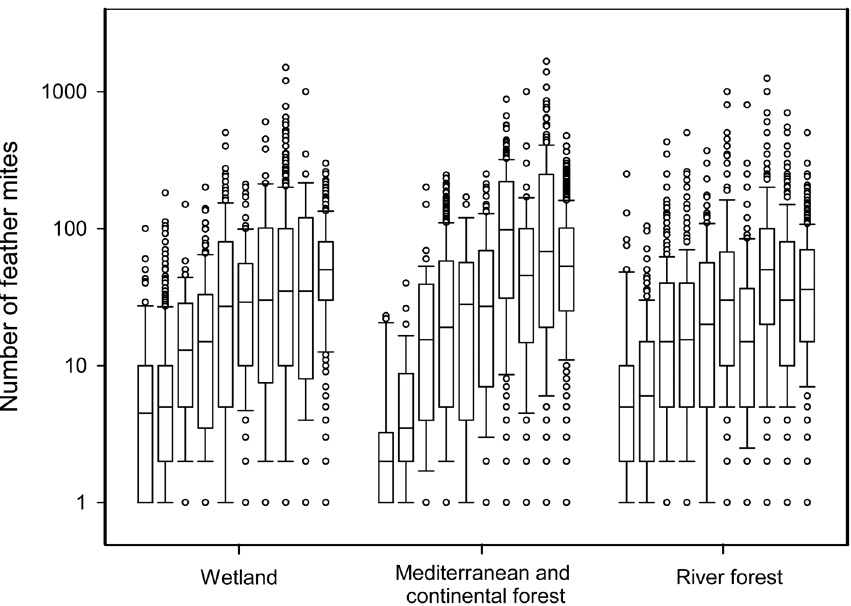
Figure 7. Boxplot of feather mite intensity for ten different species of well-sampled resident passerines in three habitats. Species are ordered from left to right within each habitat according to the intensities of feather mites in individuals captured in wetlands, as follows: Phylloscopus collybita, Acrocephalus scirpaceus, Luscinia megarhynchos, Erithacus rubecula, Cettia cetti, Fringilla coelebs, Cyanistes caeruleus, Carduelis chloris, Serinus serinus and Sylvia atricapilla . ‘‘Breeding’’, ‘‘habitat’’ and four variables from the spatial autocorrelation term were retained as fixed factors in LME, while ‘‘observer’’ and ‘‘species’’ were included as random factors.